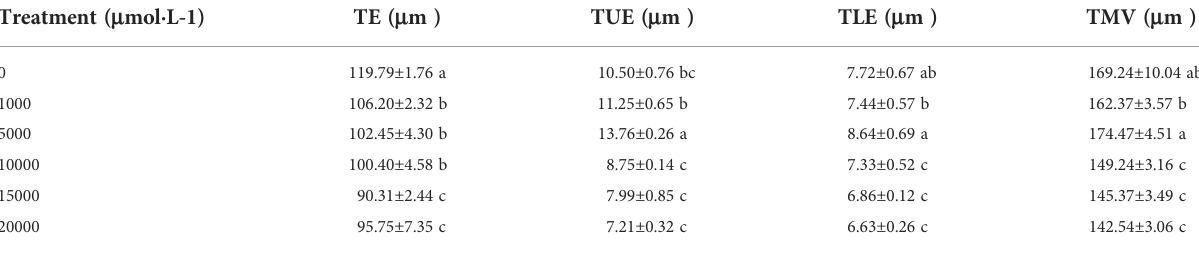
TABLE 3 The effects of Mn treatments on epidermal tissue and main vein structure in D. carota .